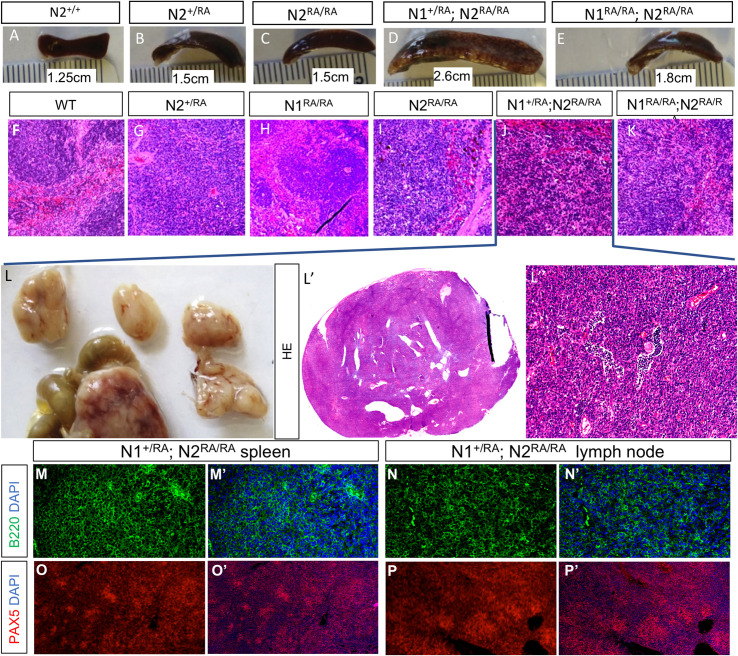
Aged N2RA/RA and N2RA/RA; N1+/RA mice develop severe splenomegaly and tumors reminiscent of SMZL.A-E. Images of spleens from mice P600-P700 with indicated genotypes. F-K. Severely enlarged spleens are associated with disorganized morphology and the appearance of cells with large nuclear:cytoplasmic ratio (genotypes indicated, see low magnification image in S6E Fig). L. Large enteric lymph nodes detected in the individual shown in (J.), densely populated with cells with large nuclear:cytoplasmic ratio (L’-L”.). Staining the spleen (M.) and lymph node (N.) with Ki67 and the B-cell markers B220 and Pax5 identifies infiltrating cells as spleen-derived B cells. Magnification: 10×. N2RA/RA; N1+/RA, Notch1/Notch2 RA homozygous; RA, Arg (N1R1974/N2R1934) to Ala substitution; SMZL, splenic marginal zone B-cell lymphoma.